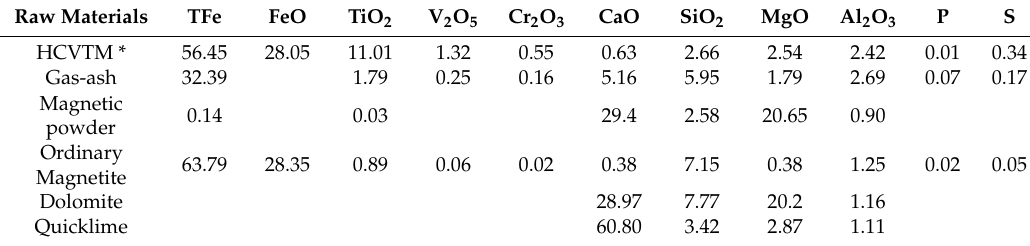
Table 1. The chemical compositions of raw materials (wt %).